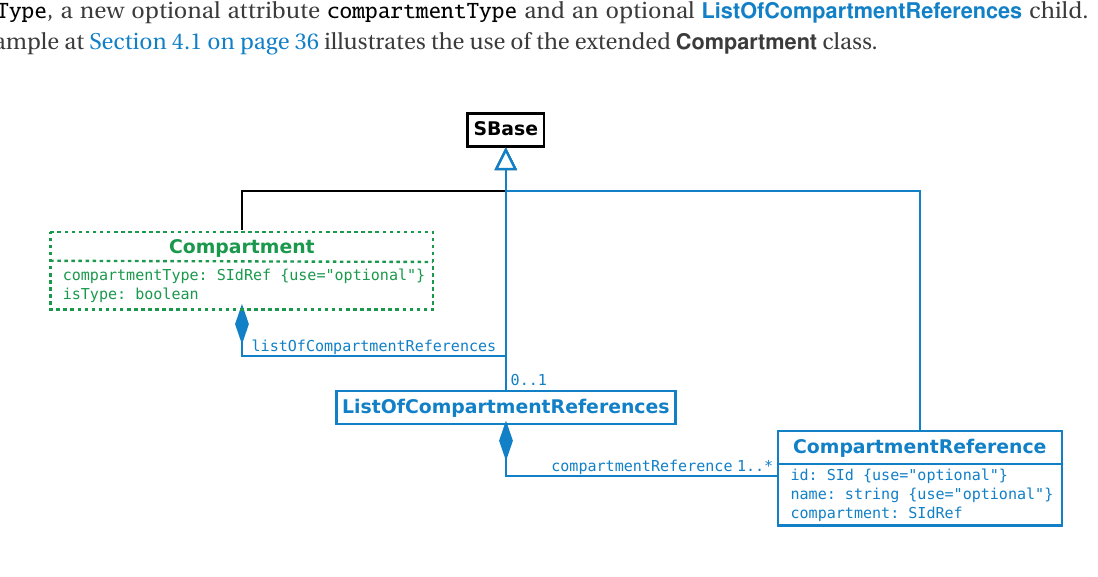
Figure 2: The definitions of Compartment , ListOfCompartmentReferences and